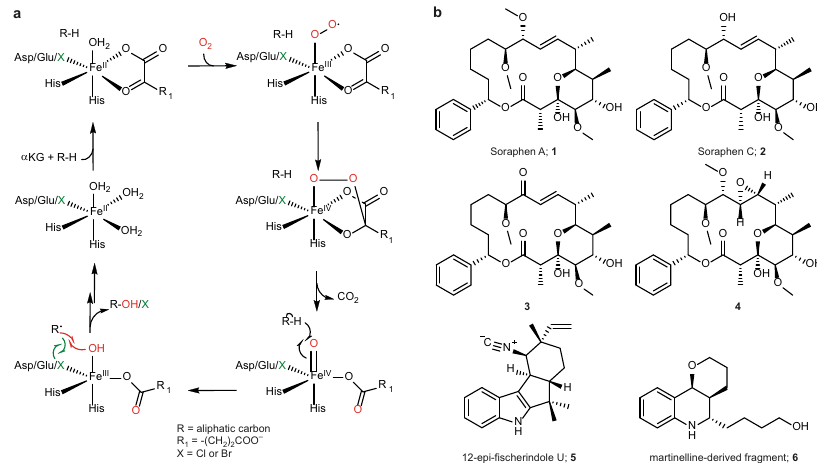
Fig. 1 Proposed reaction mechanism and substrates of wild type and engineered WelO5* variants. a Proposed reaction mechanism of Fe(II)/ α KG- dependent halogenases and hydroxylases. Mechanism adapted from Mitchell et al. 66 and Galonic et al. 79 b Structural comparison of the macrolide soraphen A and its analogs ( 1-4 ) with WelO5* ’ s natural substrate 12-epi- fi scherindole U ( 5 ) 22 and the accepted martinelline-derived fragment ( 6 )